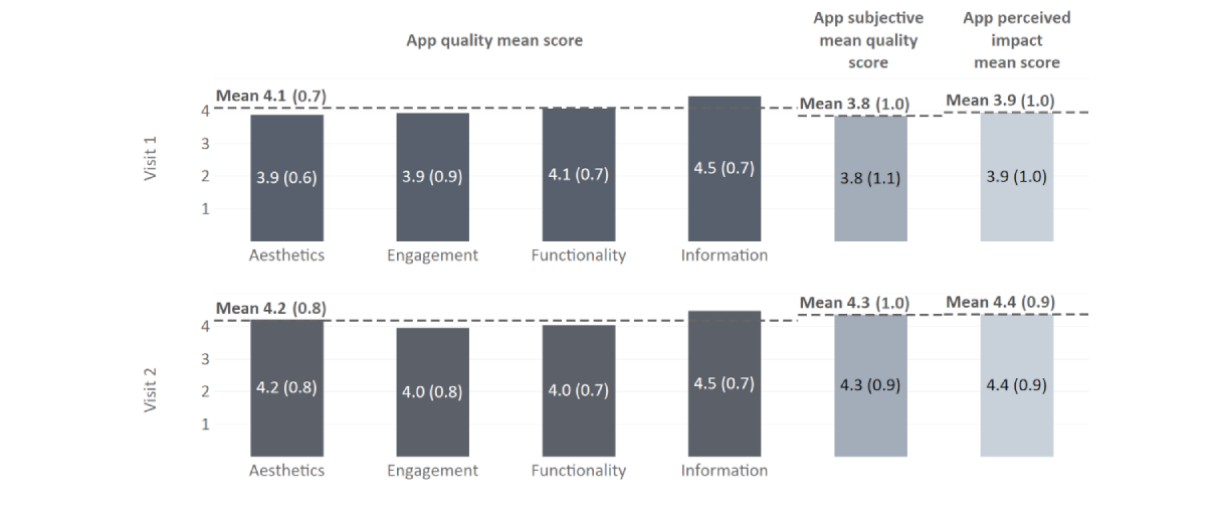
Figure 3. Results of the user version of the Mobile Application Rating Scale in the TRIANGLE user study stratified by visit and subscale (n=8; all values as mean [SD]).